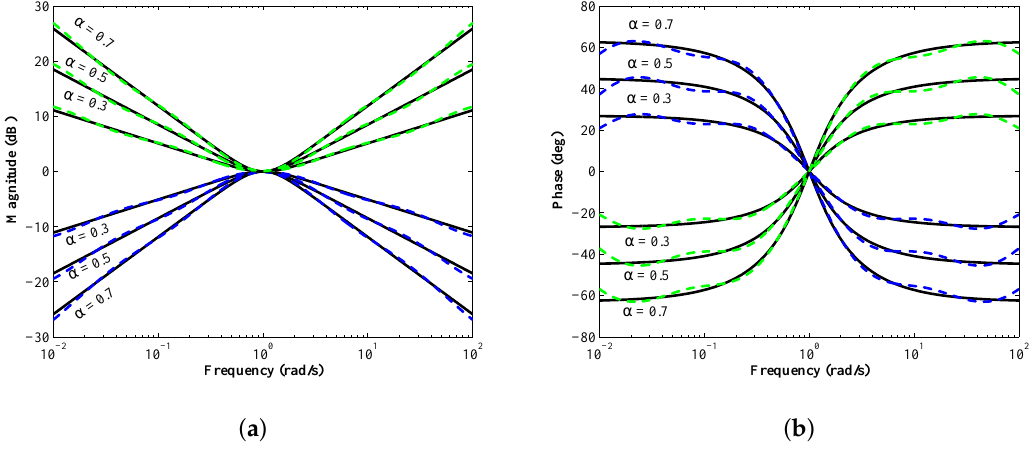
Figure 5. ( a ) Magnitude and ( b ) phase–frequency responses of the proposed BPPLFs (dashed blue) and IBPPLFs (dashed green) as compared to the theoretical ones (solid black).